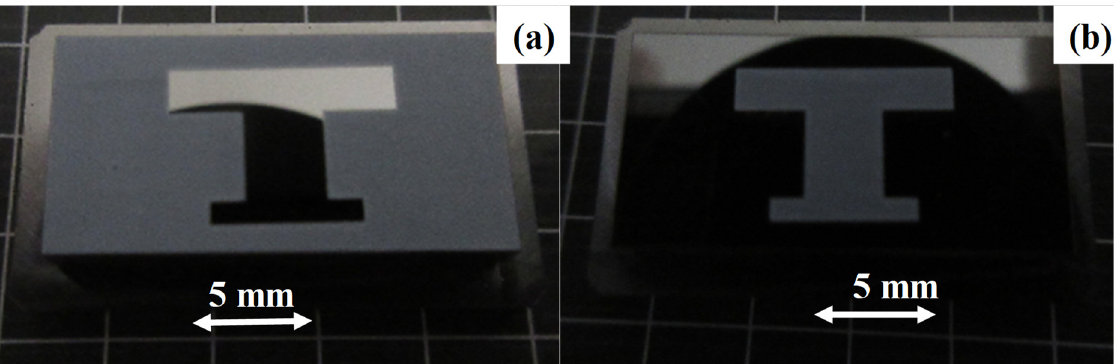
Figure 4. Screen printing of micropatterns onto the AISI316L substrate surface. ( a ) Printing the negative pattern to T-shaped motor-core sheet unit onto the die surface, and ( b ) printing its positive pattern onto the die surface.